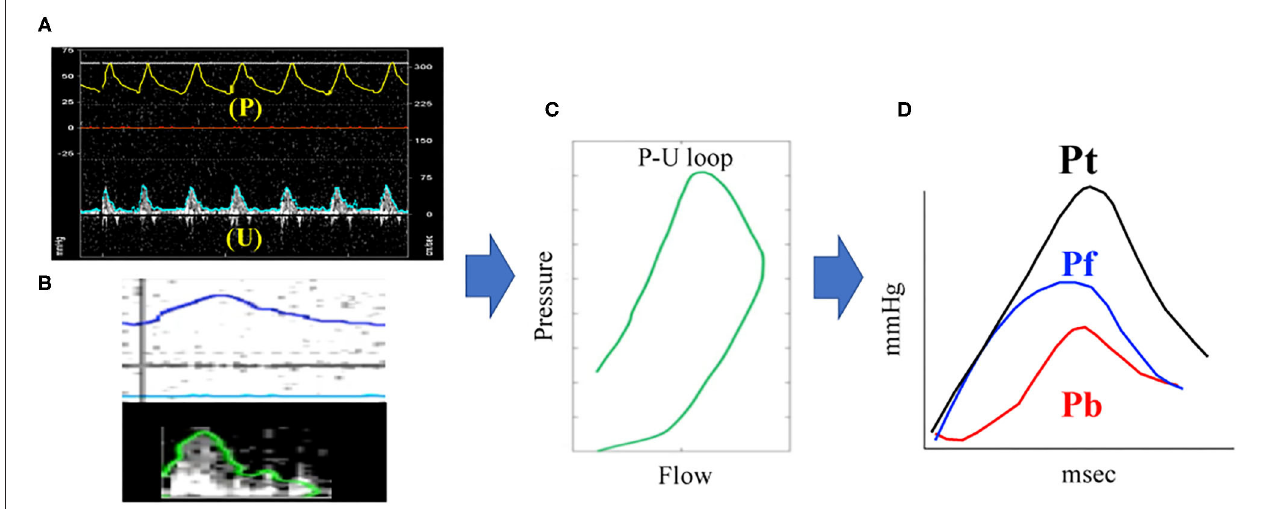
FIGURE 1 | PAWR assessment by right heart catheterization. Process of (A–D) were processed using an in-house program code written in MATLAB. (A) , pulmonary artery pressure (P) and flow (U) gained by a dual sensor-tipped pressure and flow wire simultaneously. (B) , Contour detection of P and U. The P and U waveforms measured directly with the catheter were smoothed using a Savitzky–Golay filter and then ensemble-averaged over three cardiac cycles. (C) , Determination of the P-U loop. (D) , PAWR indices gained by wave separation analysis. PAWR, Pulmonary arterial wave reflection; Pt, Total pressure; Pf, Forward pressure; Pb, Backward